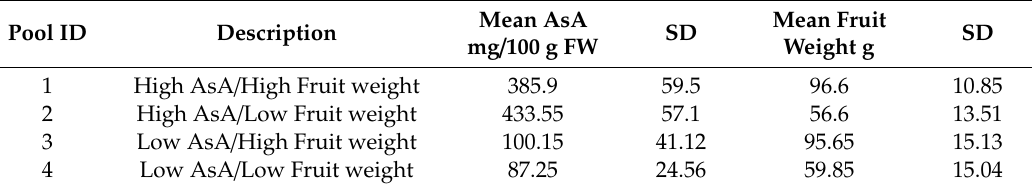
Table 3. Summaries of sequencing pool